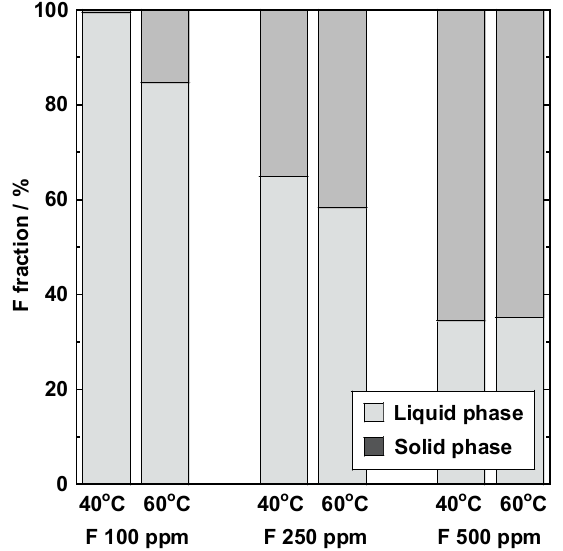
Figure 10. Solid / liquid fluorine distributions at temperatures of 40 and 60 ◦ C. Metals 2020 , 10 , x FOR PEER REVIEW Figure 10. Solid/liquid fluorine distributions at temperatures of 40 and 60 ° C.